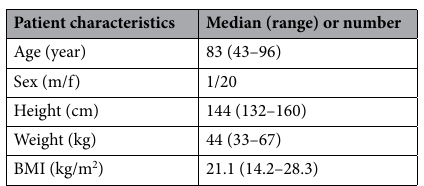
Table 1. Patient characteristics.